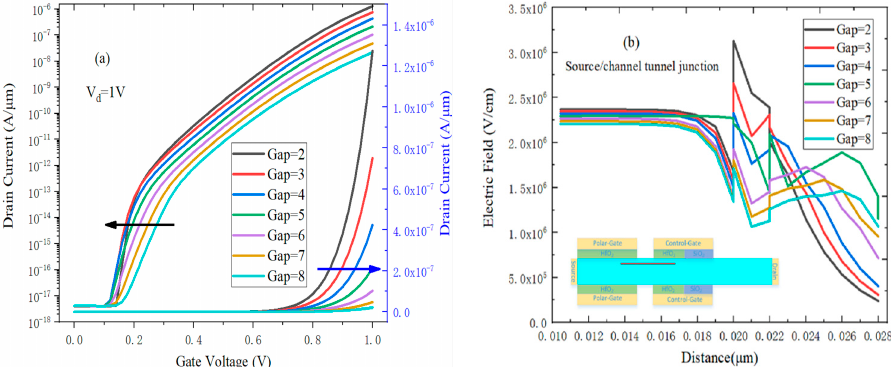
Figure 7. The effect of the gap length between the polar-gate and control-gate on the device performance. ( a ) Transfer characteristics; and ( b ) electric field of the tunnel junction under the on state.